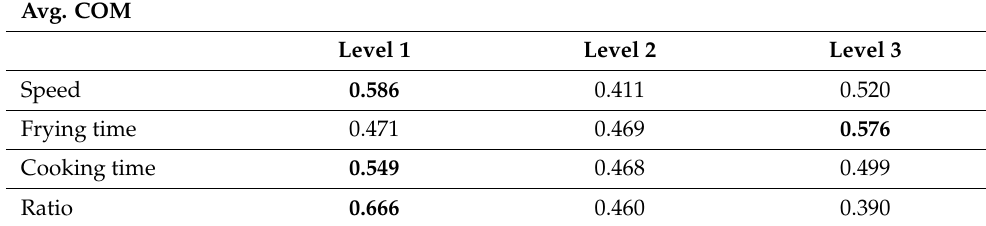
Table 14. The average of the COM values at each factor level.